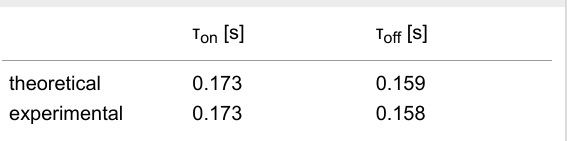
Table 1: Relaxation times of 5CB.